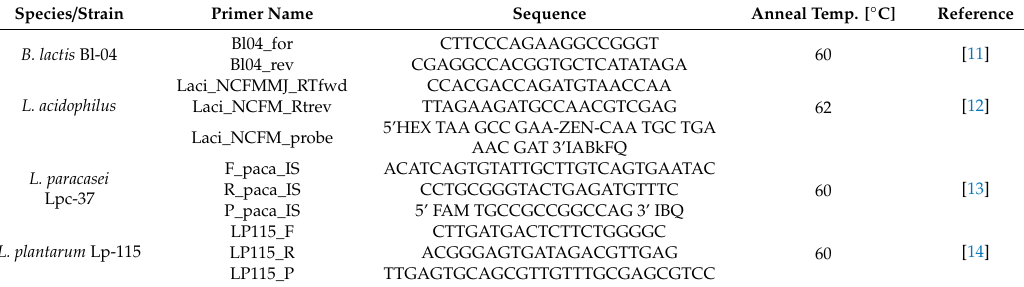
Table 1. Primer sequences and annealing